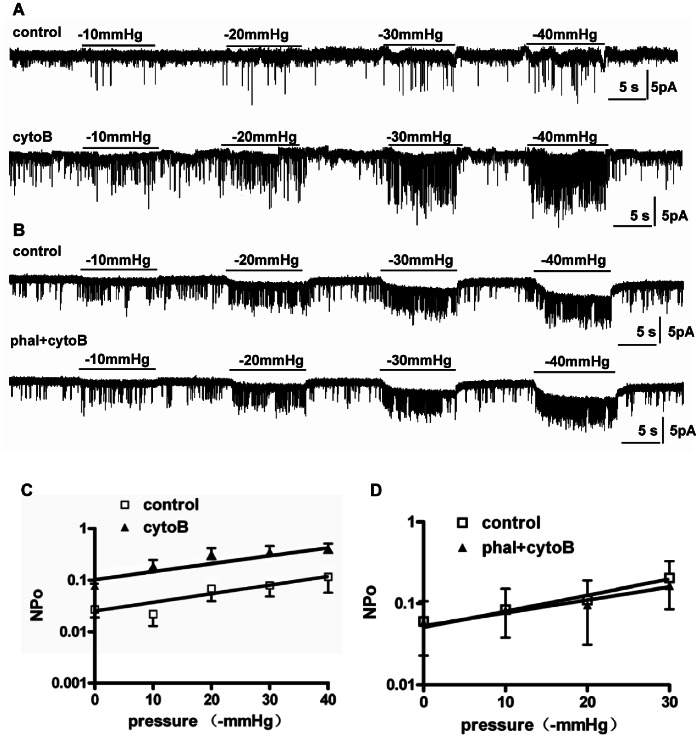
Effect of cytoB on the response to pressure steps.A: Recordings from a patch before and after cytoB treatment. B: Recordings in another patch before and after exposure to phalloidin (10 µM) followed by cytoB (20 µmol/L) (phal+cytoB). C: The semilog plots of NPo-pressure relationship before and after treatment with cytoB. The two semilog plots are parallel while the intercept is increased by cytoB (n = 6; P<0.05) suggesting cytoB increases the background activity only. D: The semilog plots of NPo-pressure relationship before and after treatment with phalloidin followed by cytoB (phal+cytoB). The two semilog graphs coincides and the increment in background activity induced by cytoB was abolished by application of phalloidin in advance (n = 5; P>0.05).